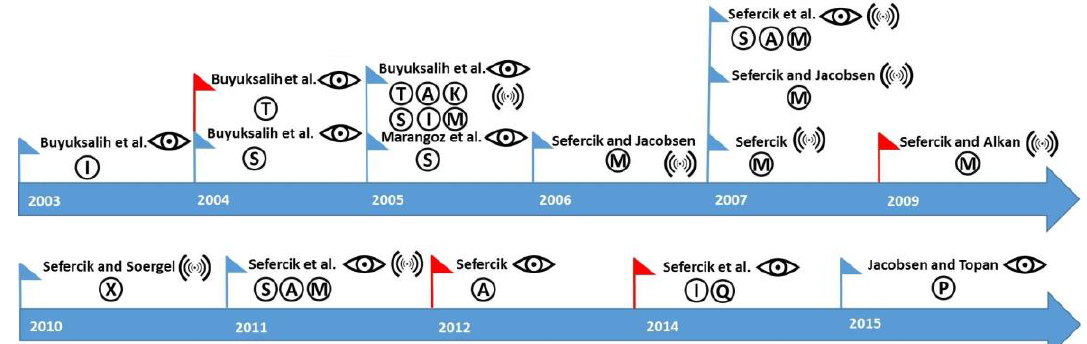
Figure 4. Summary of previous studies of DEM generation and validation.